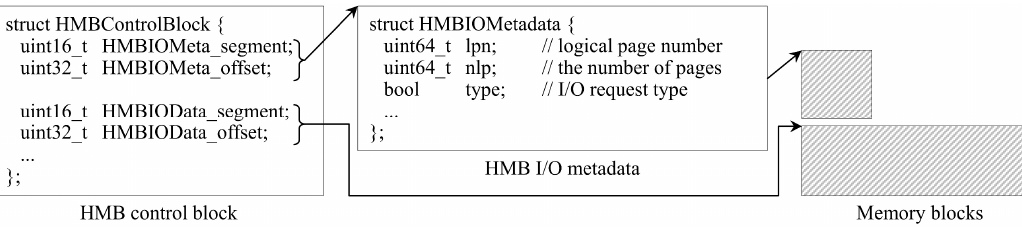
/ O data Figure 6. HMB I/O data structures. Figure 6. HMB I